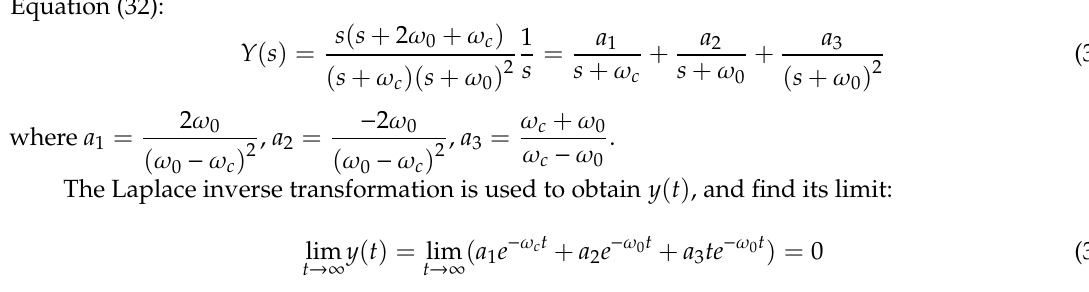
Figure 7. Angular frequency characteristic curve of disturbance rejection term ( a ) ω c = 100 ( b ) ω 0 =